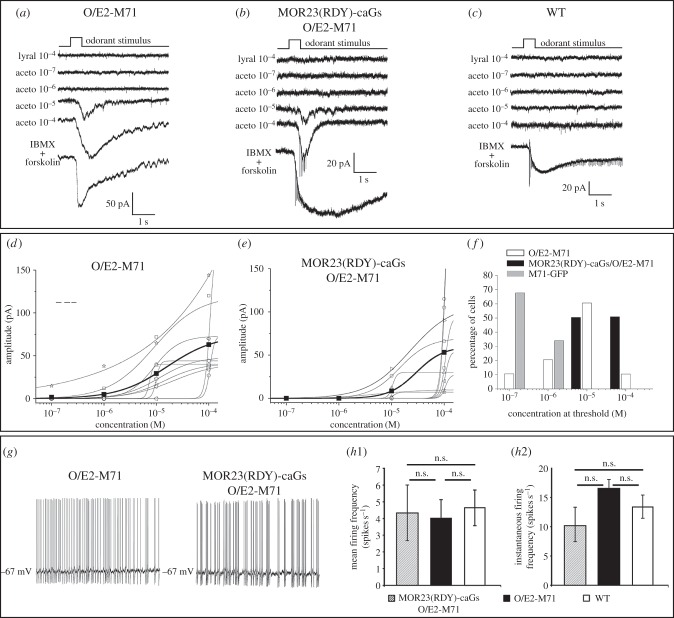
Ectopically expressed O/E2-M71 elicits both agonist-dependent and -independent neuronal activities. (a–c) Representative traces of perforated patch-clamp recordings in the voltage-clamp mode in response to the indicated ligands in (a) random OSNs or (b) MOR23(RDY) → M71-caGs-Tomato OSNs in O/E2-M71-GFP heterozygous mice; (c) random OSNs in a WT mouse. (d,e) Dose–response curves of acetophenone stimulated (d) random OSNs or (e) MOR23(RDY) → M71-caGs-Tomato OSNs in O/E2-M71-GFP heterozygous mice. The curve for the average is in black. (f) A threshold frequency histogram for random OSNs (white bar, n = 10) or MOR23(RDY) → M71-caGs-Tomato OSNs (black bar, n = 10) in O/E2-M71-GFP heterozygous mice, and M71-GFP OSNs in O/E2 WT mice (grey bar, n = 6). This histogram represents the number of cells with a detection threshold in the 10−7, 10−6, 10−5 or 10−4 M range of stimulating concentration. (g) Representative traces of spontaneous activities recorded through perforated patch-clamp in the current clamp mode from random OSNs or MOR23(RDY) → M71-caGs-Tomato OSNs in O/E2-M71-GFP heterozygous animals. (h1) Mean spontaneous firing frequency and (h2) IF for the same OSN types described in (a–c). n = 6, 13, 10, respectively. Data are mean ± s.e.mb. One-way ANOVA and Tukey post test.